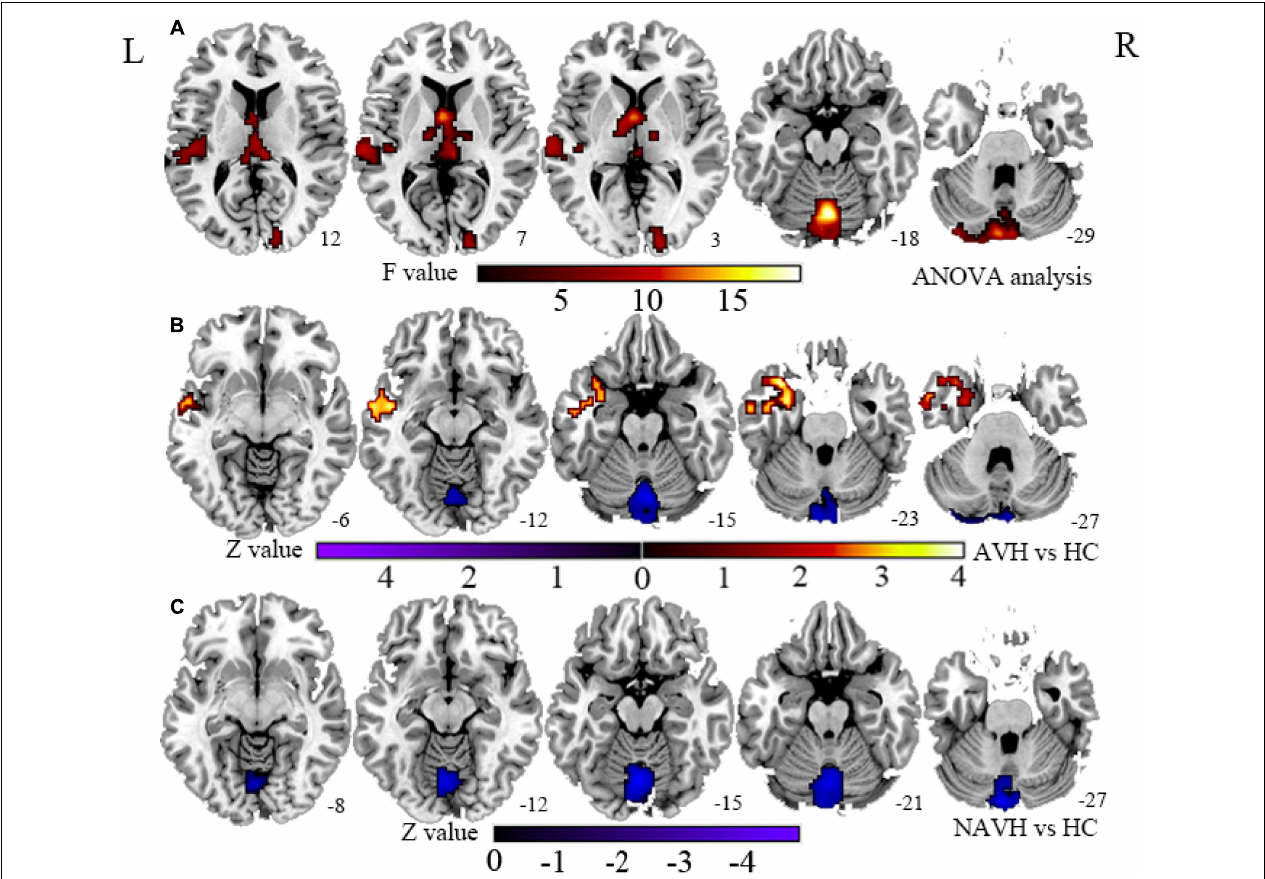
FIGURE 4 | (A) CBF/FCS ratio results for HC, AVH, and NAVH groups at a voxel-level height threshold of p < 0.005 (two sided) and cluster size GRF corrected threshold of p < 0.05. (B) Brain regions with significant CBF/FCS changes in the AVH group. (C) Brain regions with significant CBF/FCS changes in the NAVH group. CBF, cerebral blood flow; FCS, functional connectivity